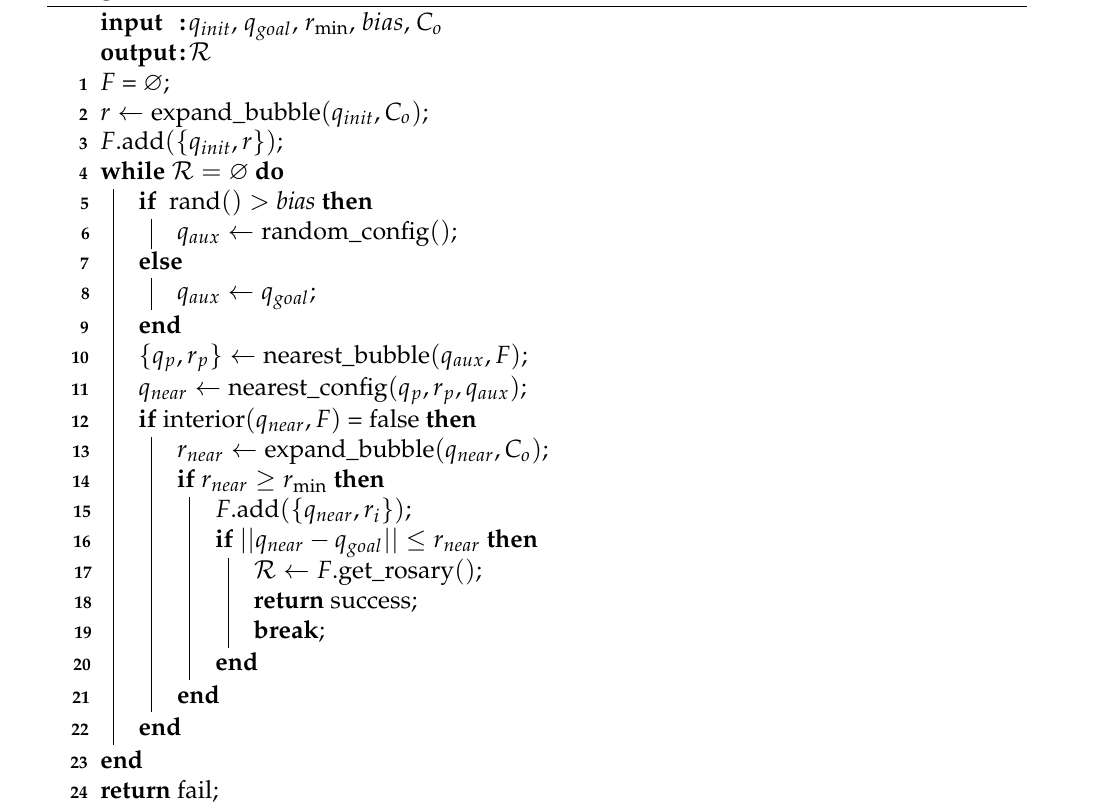
Algorithm 2: Goal-biased Probabilistic